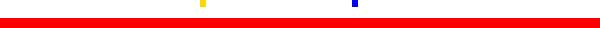
A graphic map of the distribution of the target-DNA sites recognized by the two ZFNs obtained along the entire length of the SIV/HIV-pol-gene. This figure offers a graphic map of the distribution of target DNA sites recognized and cleaved by our two ZFNs, along the full 3,182 bp lengths of the SIV/HIV-pol gene. For details, see Table 2 and Additional file 2.